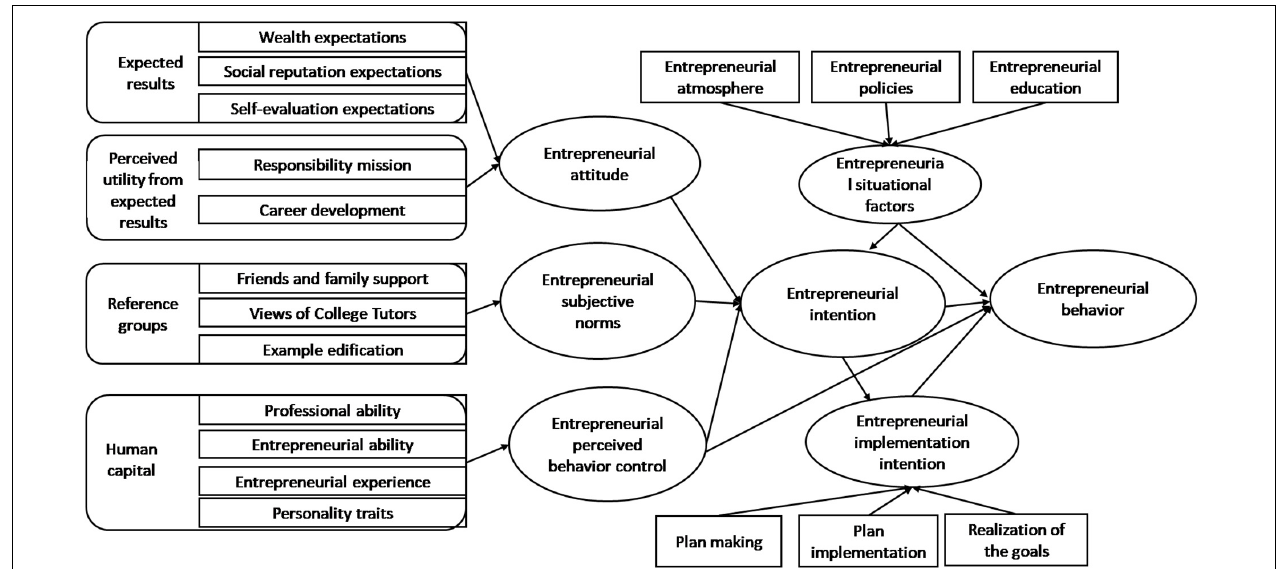
FIGURE 2 | The College students’ entrepreneurial intention—behavior extended